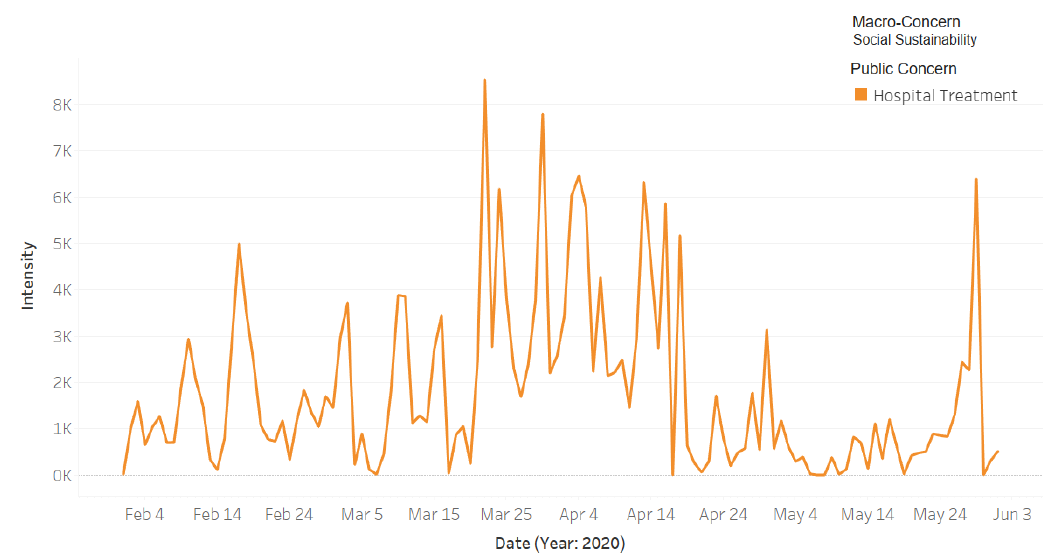
Figure 11. Daily Twitter activity for a public macro-concern (social sustainability).